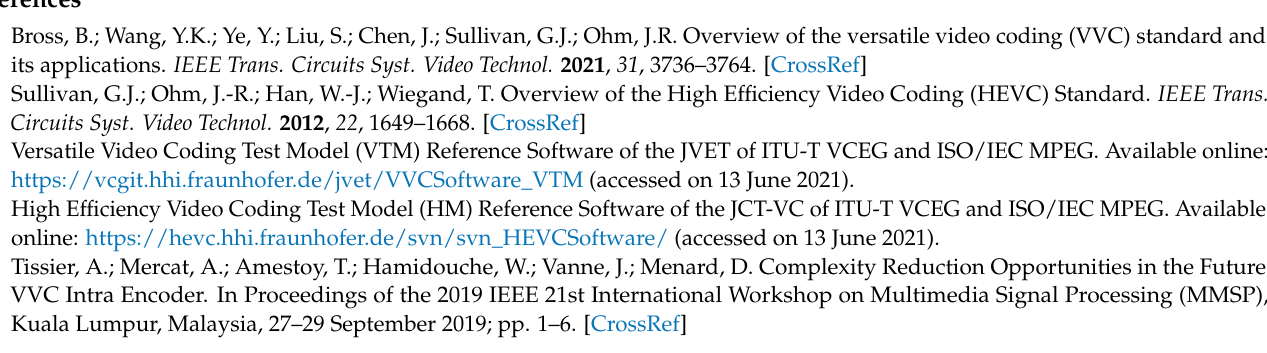
Figure 10. The RD curves: ( a ) the RD curve of FourPeople; ( b ) the RD curve of Johnny.